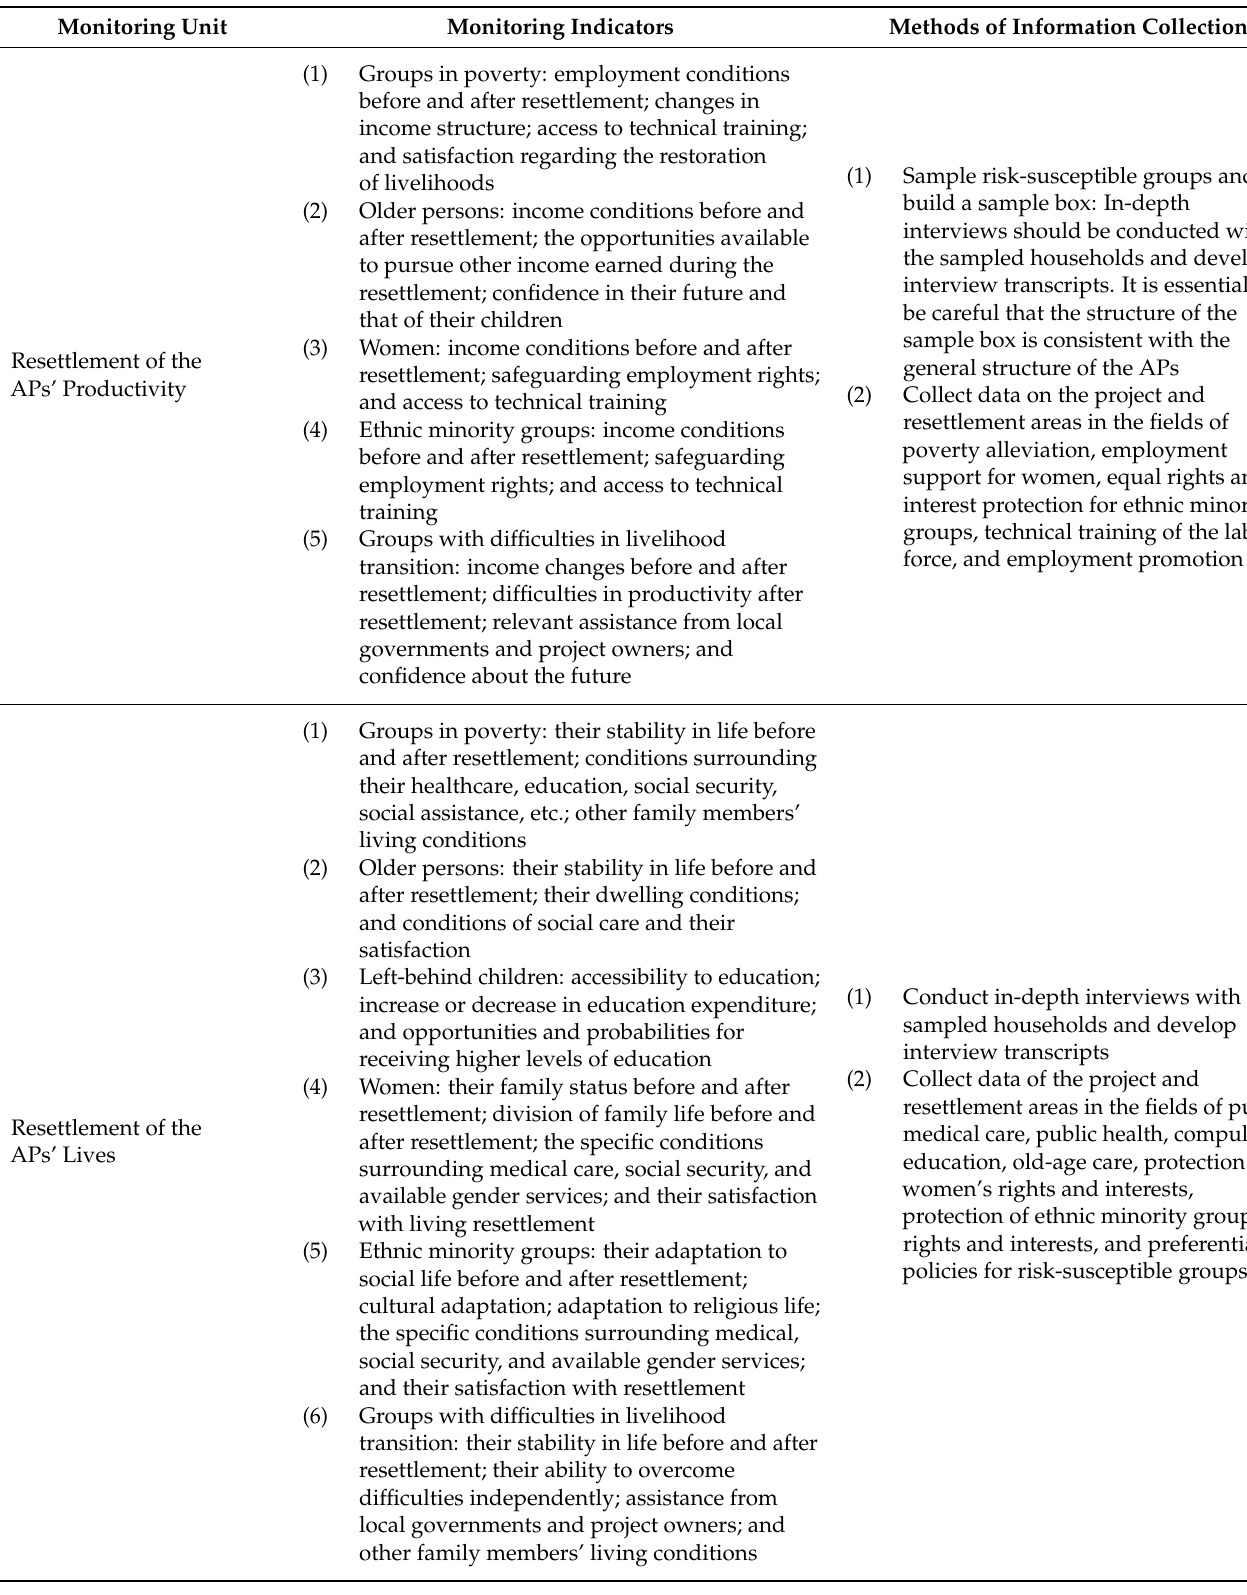
Table 1. Monitoring of Risk-susceptible